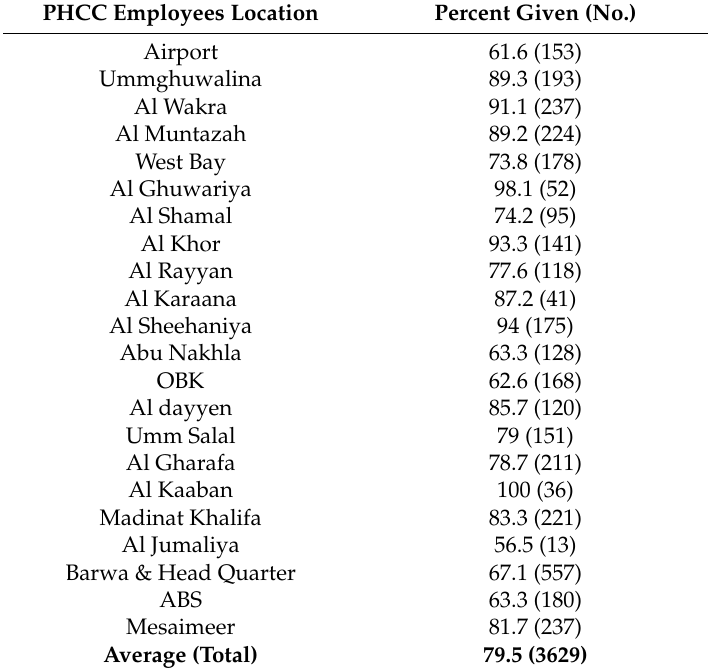
Figure 1. Influenza vaccine coverage in primary health care centers in Qatar, 2015. ( a ) Total coverage of influenza vaccine among PHCC employees; ( b ) Coverage of influenza vaccine among PHCC employees per health center. Table 1. Coverage of influenza vaccination per primary healthcare center ( n = 22) in Qatar. PHCC Employees Location Percent Given (No.)